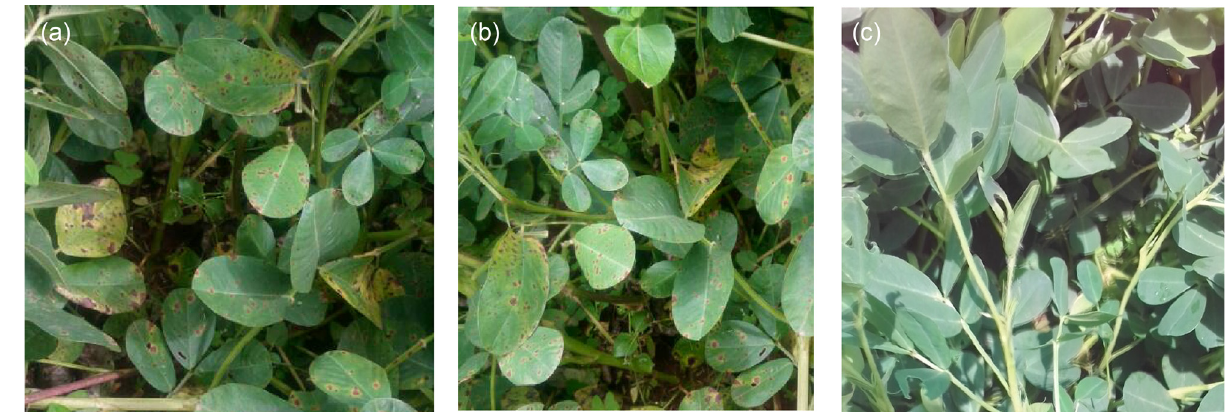
Figure 1: Resistance or susceptibility level of ( a ) “ fl eur ” 11 var., ( b ) 65 - 13 var. and ( c ) village var. against leaf